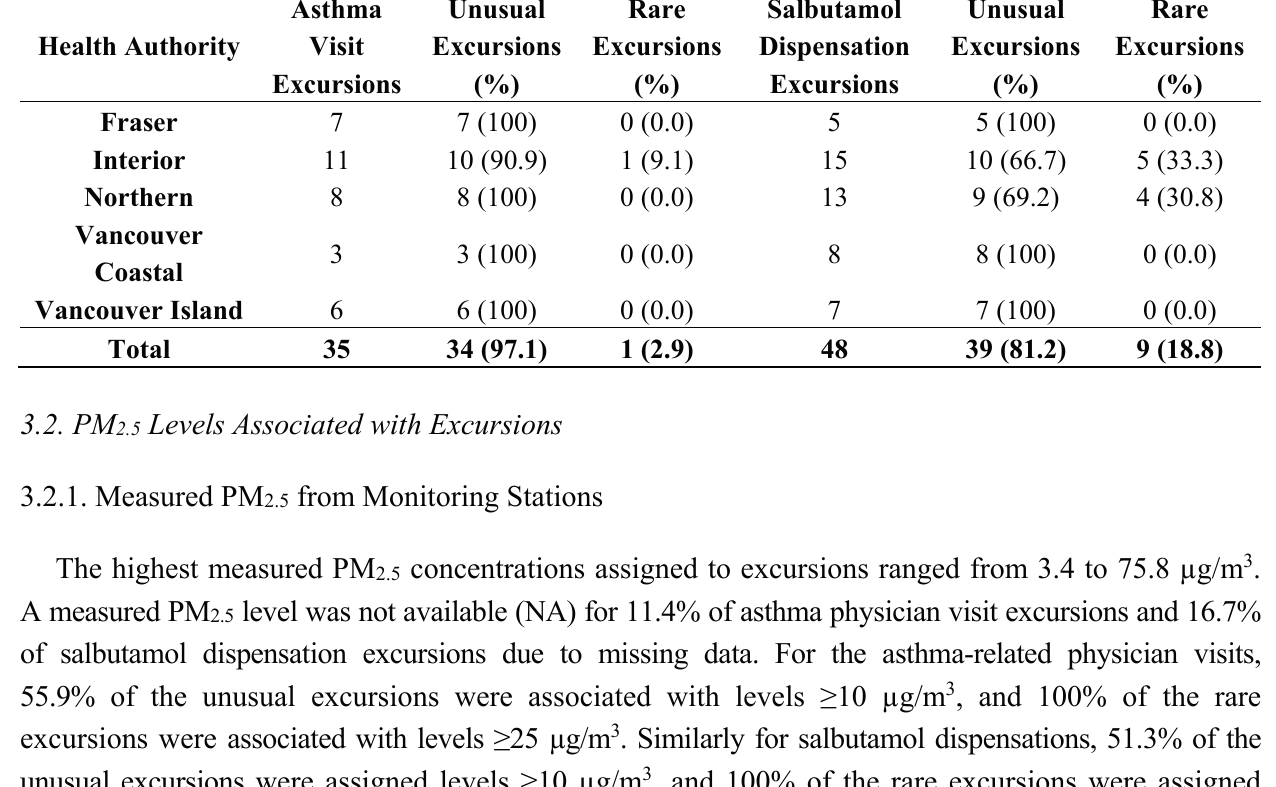
Table 1. Summary of excursions for asthma physician visits and salbutamol dispensations. Health